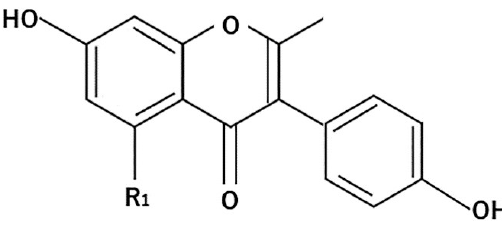
Figure 3. General structure of isoflavones .